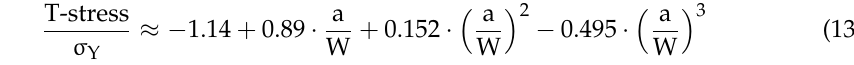
Figure 4. T-stress at limit load, normalized by yield strength, for a CC(T) specimen, as a function of relative crack length a/W [5]. The Q parameter is an elastic–plastic constraint parameter. A definition, in line with the T-stress, refers to the normalized distance between the actual tensile stress σ yy at a specified location in front of the crack and the matching value corresponding to the small- scale yielding solution for T = 0 [6]. It can be expressed in the form of Equation (14) [6]. (